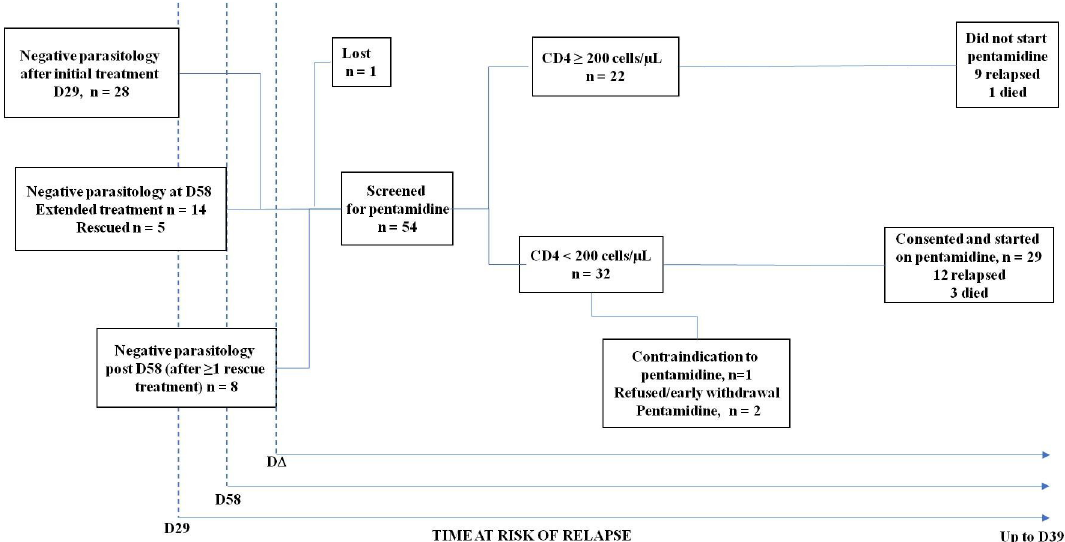
Fig 1. Follow-up period flow diagram. The maximum follow-up time was one year from initiation of VL treatment. However, patients only entered the cohort study on achieving negative parasitology. Hence, in general, patients had less than one year of follow-up in the cohort